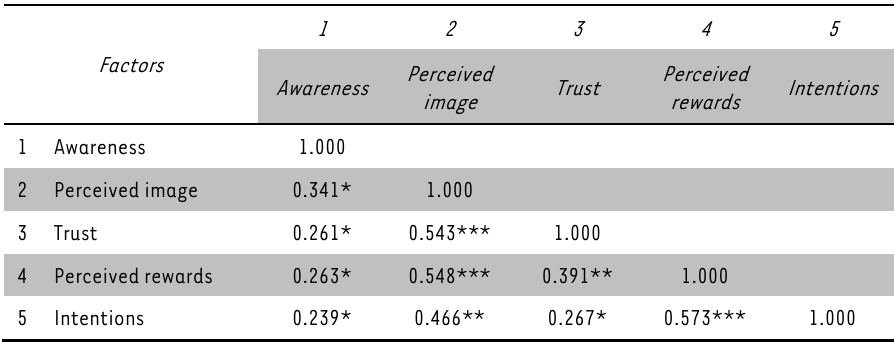
TABLE 6: Pearson’s correlations coefficients